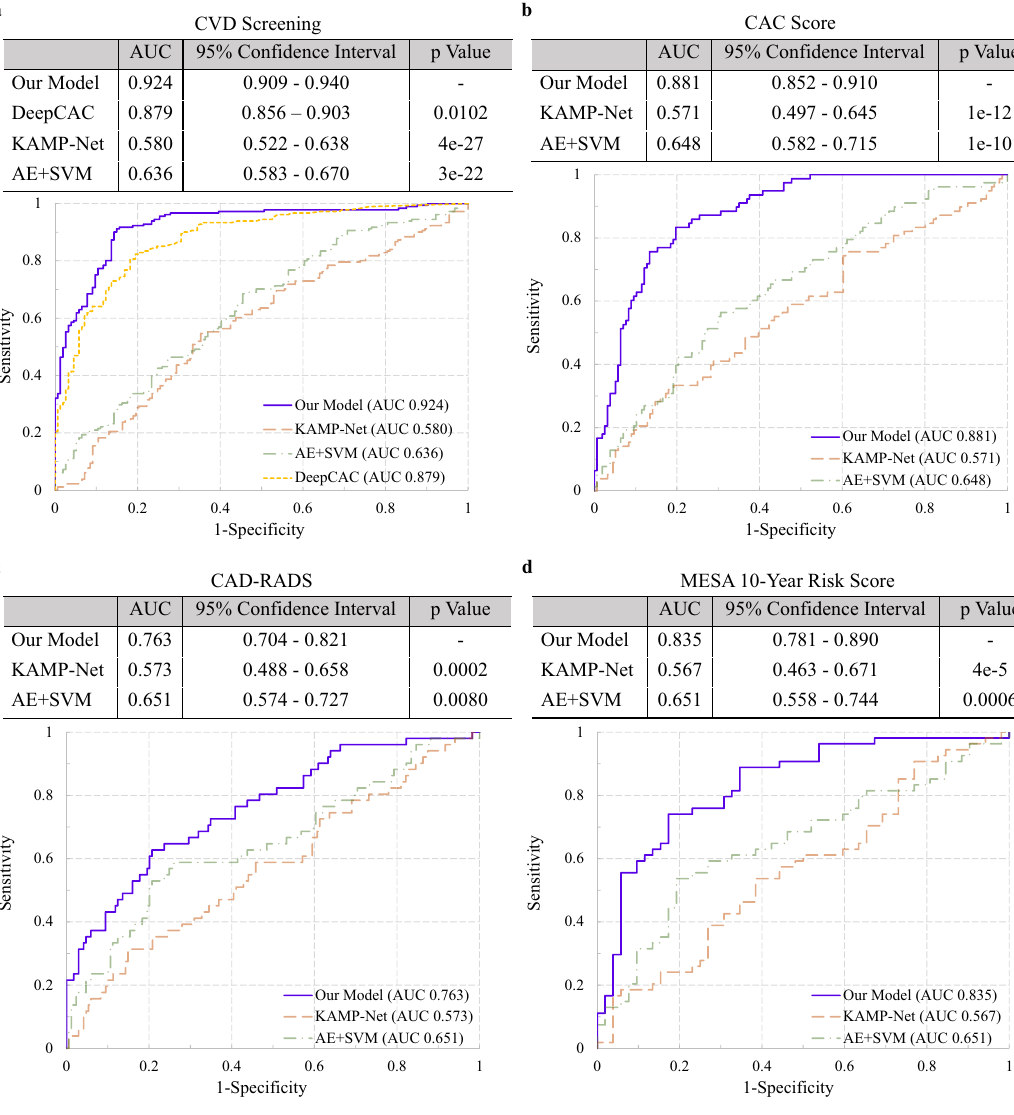
Fig. 4 Results of the four experiments on the MGH dataset. ( a ) Validation of CVD screening. b – d Comparison of our deep learning model with three clinically used risk scores, including ( b ) CAC score 34 , ( c ) CAD-RADS 35 , and ( d ) MESA 10-year risk score 36 . p values were computed using a one-tail